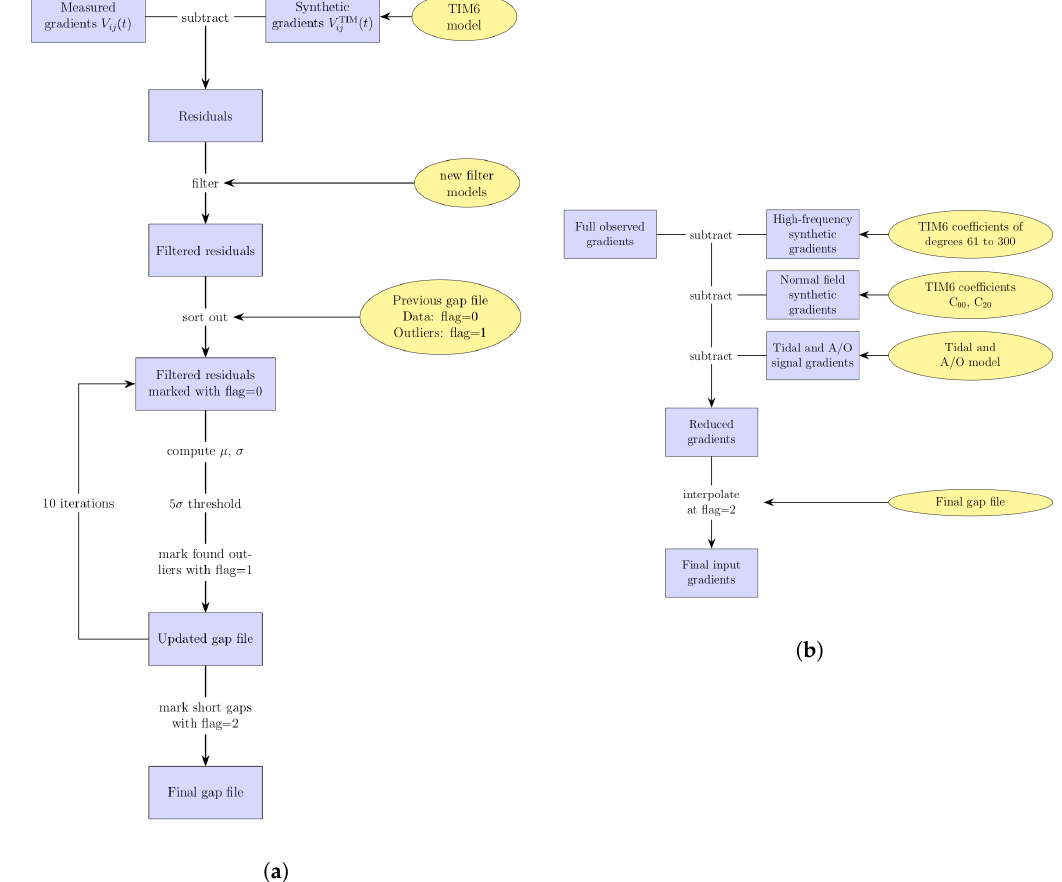
Figure 5. ( a ) Outlier detection procedure applied to create gap files for the gravity field processing. ( b ) Scheme showing the processing steps between the GOCE SGG data as provided by ESA (“full observed gradients”) and the input gradients that are used for computing SH d/o 60 gravity field